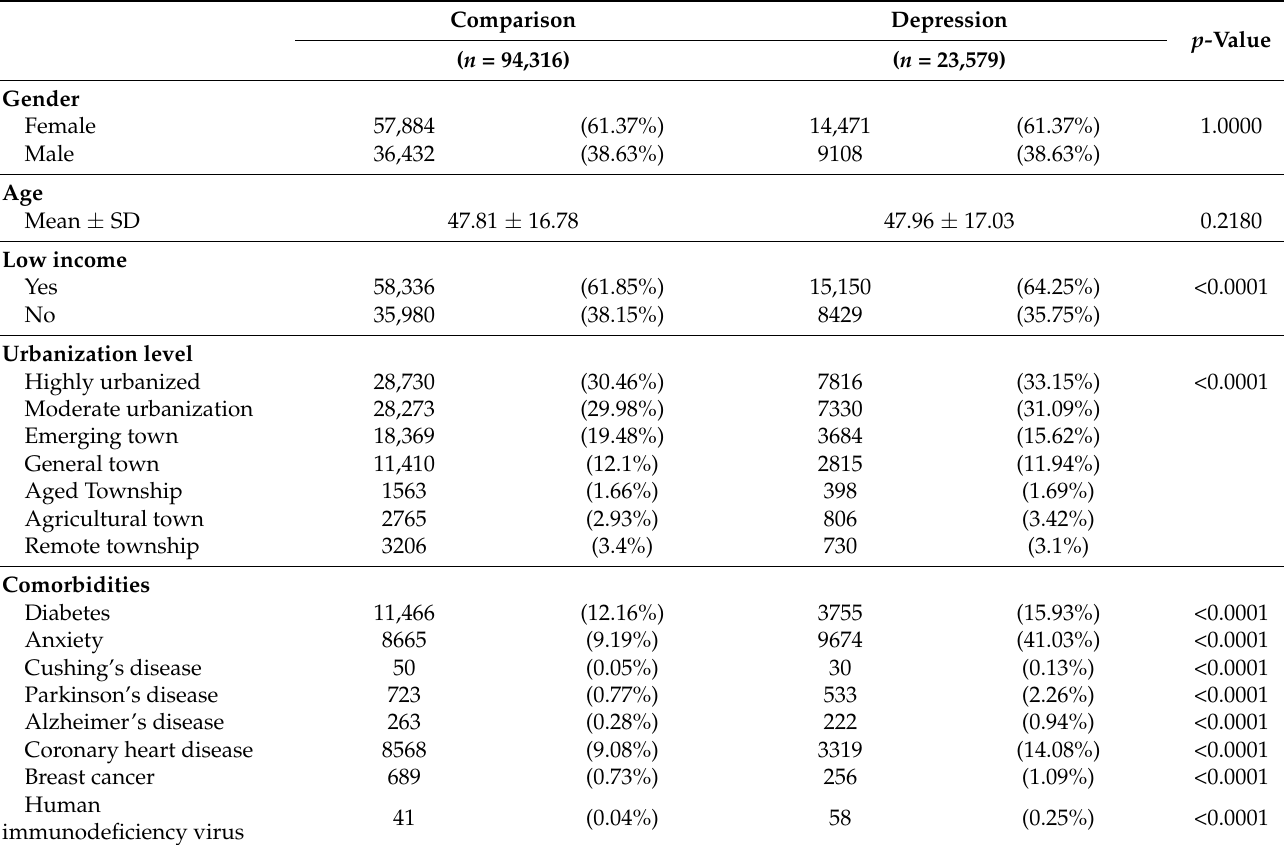
Table 1. Baseline characteristics of participants of depression and comparison.